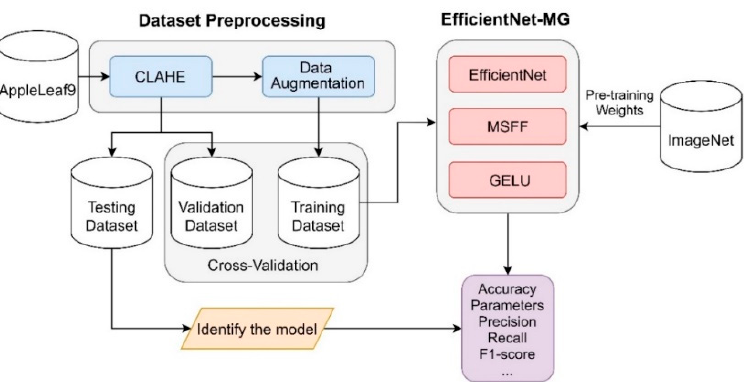
Figure 8. Block diagram of the experimental procedure.